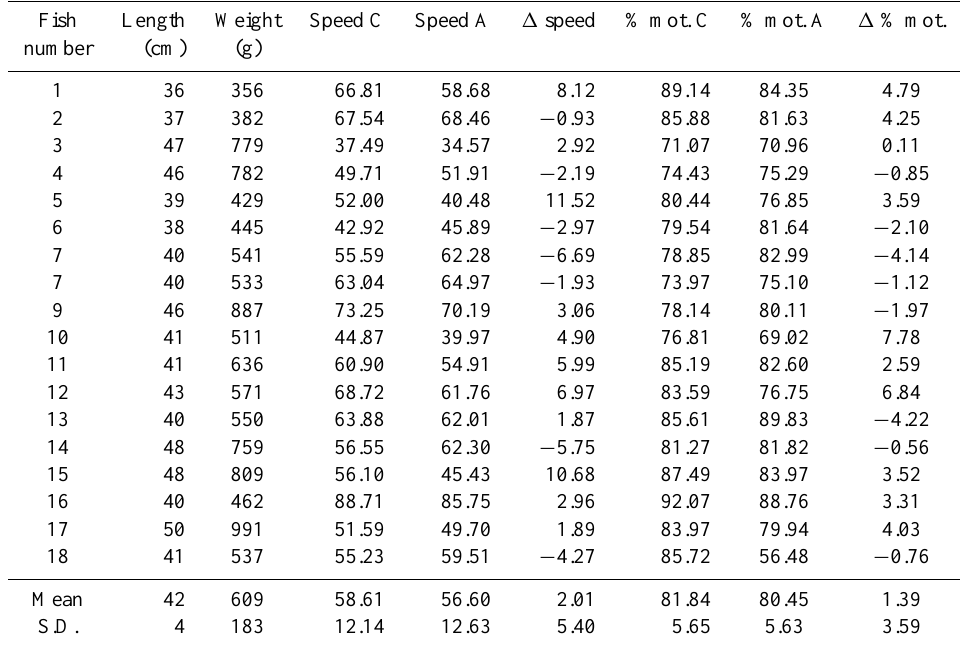
Table 2. Sperm swimming behavior in control (C) and acidified (A) conditions. Speed = mean sperm swimming speed (µms − 1 ) ; % mot. = percent motile sperm.